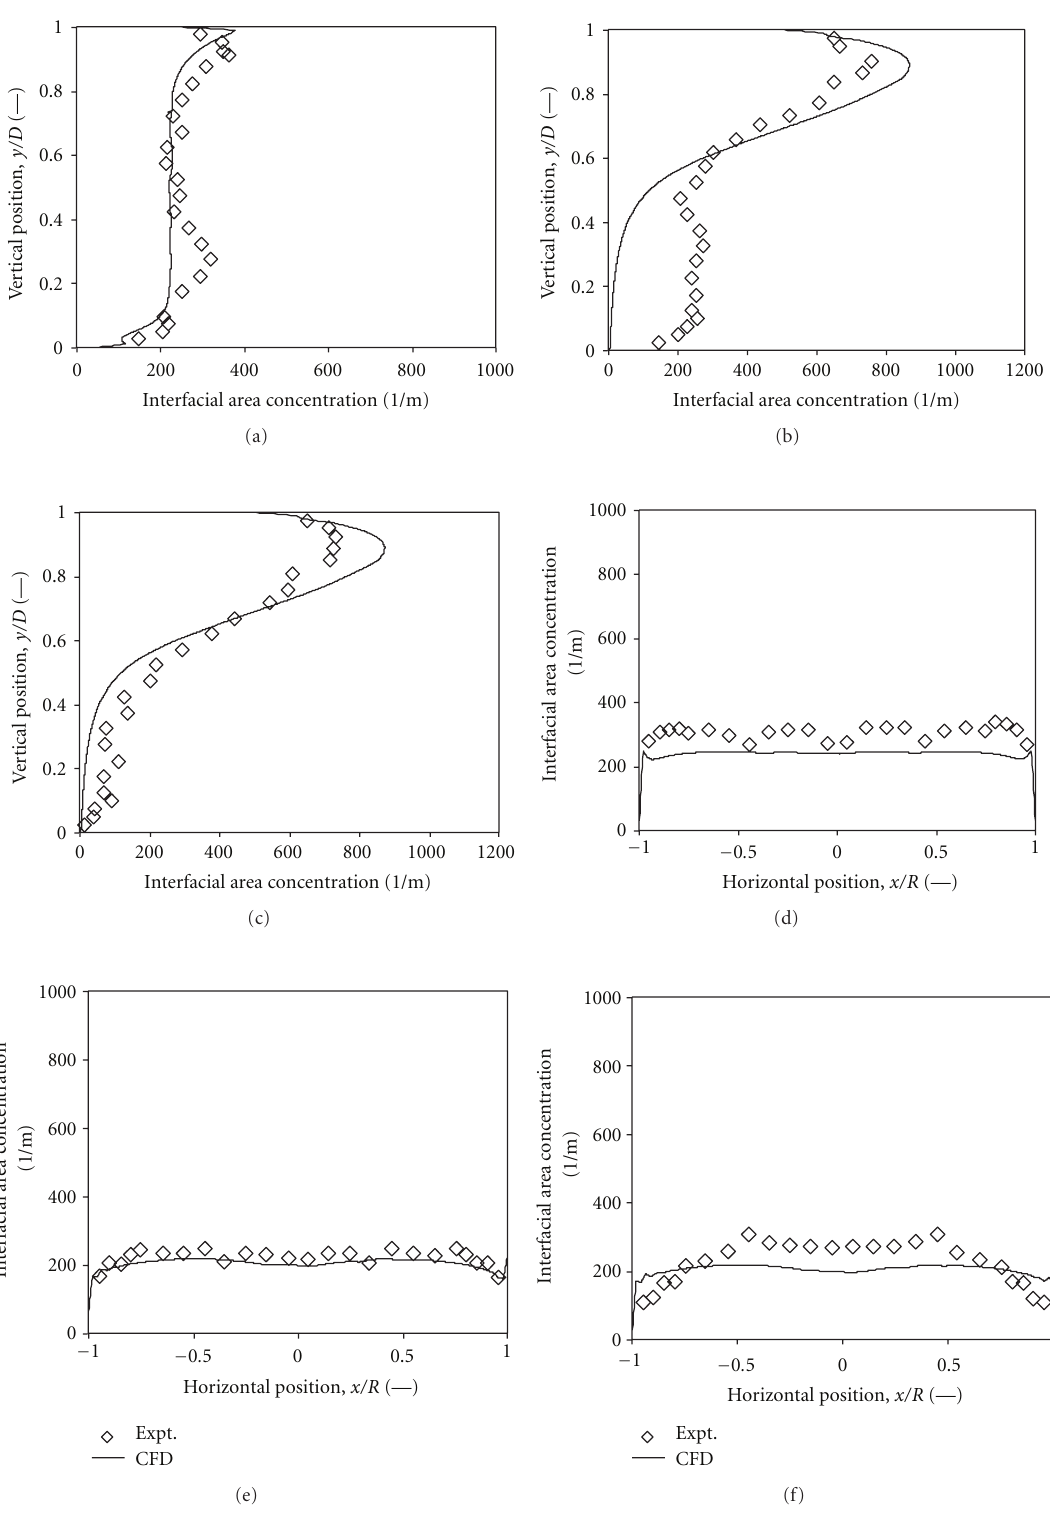
Figure 13: Interfacial area concentration (IAC) development in axial direction for superficial gas velocity is 1.21 m/s, superficial liquid velocity is 4.67 m/s, and average volume fraction is 0.205. At vertical position,(a) L/D = 25; (b) L/D = 148; (c) L/D = 253, at horizontal position,(d) L/D = 25; (e) L/D = 148; (f) L/D =